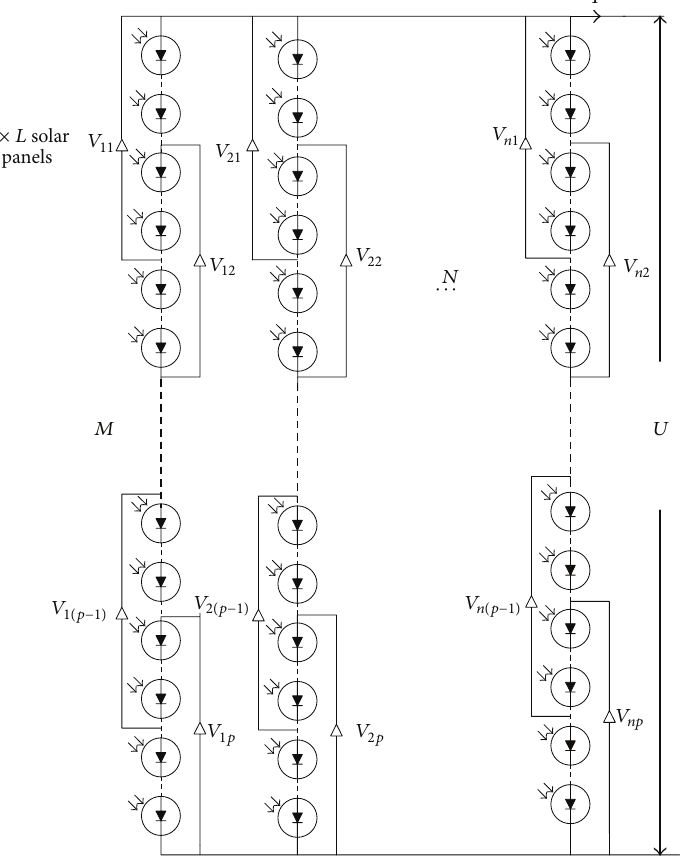
Figure 2: 𝑀 × 𝑁 detection